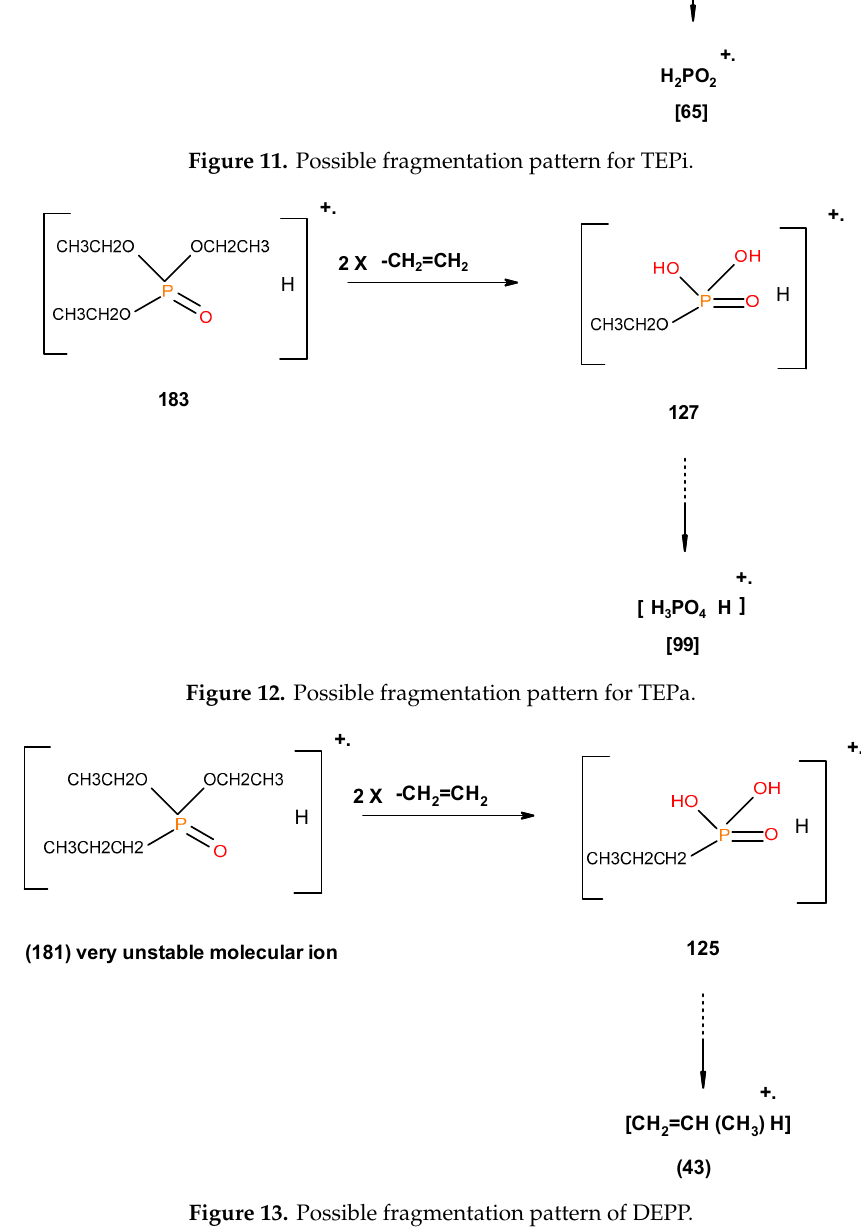
Figure 13. Possible fragmentation pattern of DEPP.